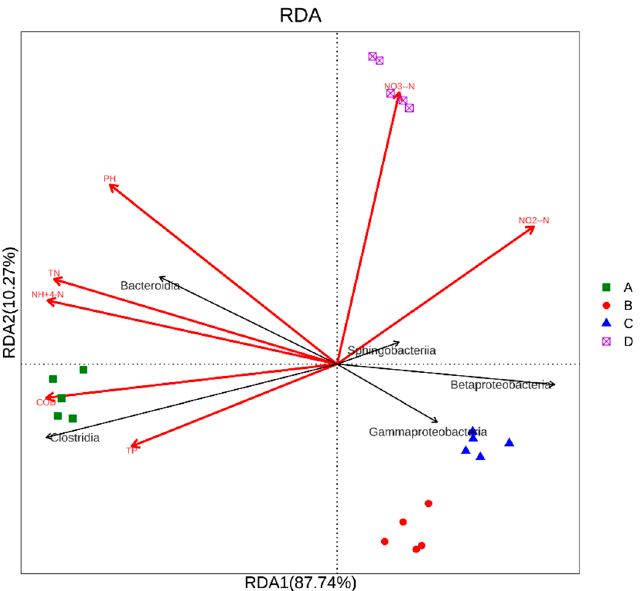
Figure 6. RDA analysis investigating the relationship between microbial communities and environ- mental variables. Note: A: inlet; B: aerobic zone; C: anoxic zone; D: anaerobic